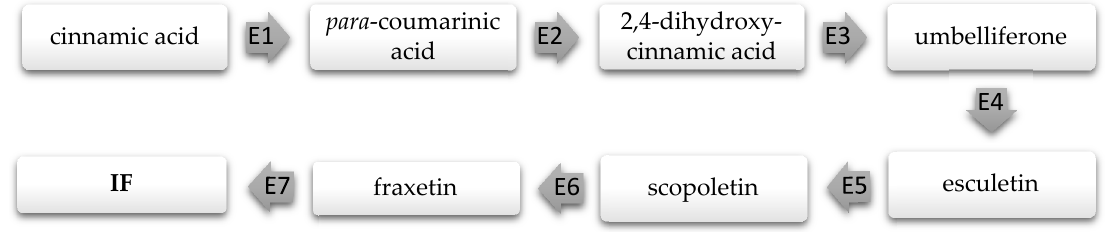
Figure 4. Proposed pathway of the IF biosynthesis. E1: Cinnamic acid 4-hydroxylase, E2: Coumarate/cinnamate/ferulate 2-hydroxylase, E3: Intramolecular lactonization, E4: Esculetin synthase, E5: Methoxy transferases, E6: scopoletin 8-hydroxylase, E7: Coumarin methyltransferase.